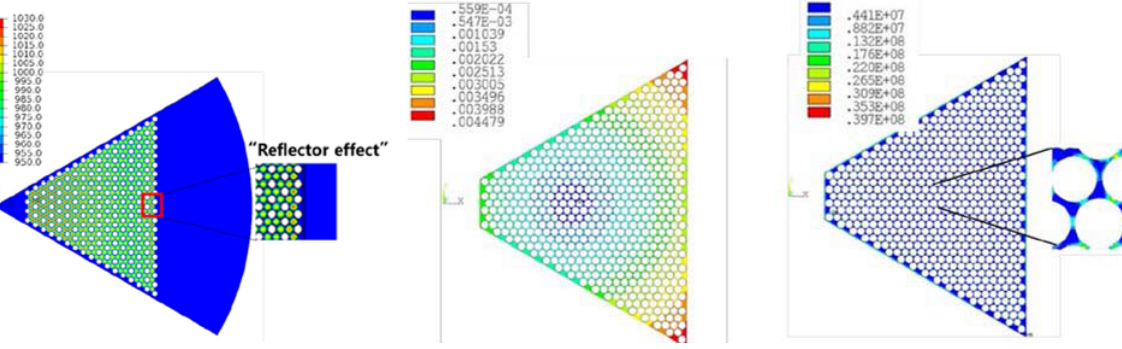
Fig. 5 K variation with the neutronic and thermal/mechanical coupling iteration eff